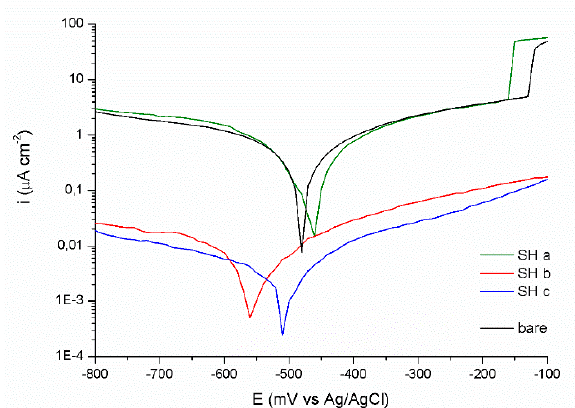
Figure 11. Cleaning efficiency as a function of void volume (Vv) parameters during the campaigns.